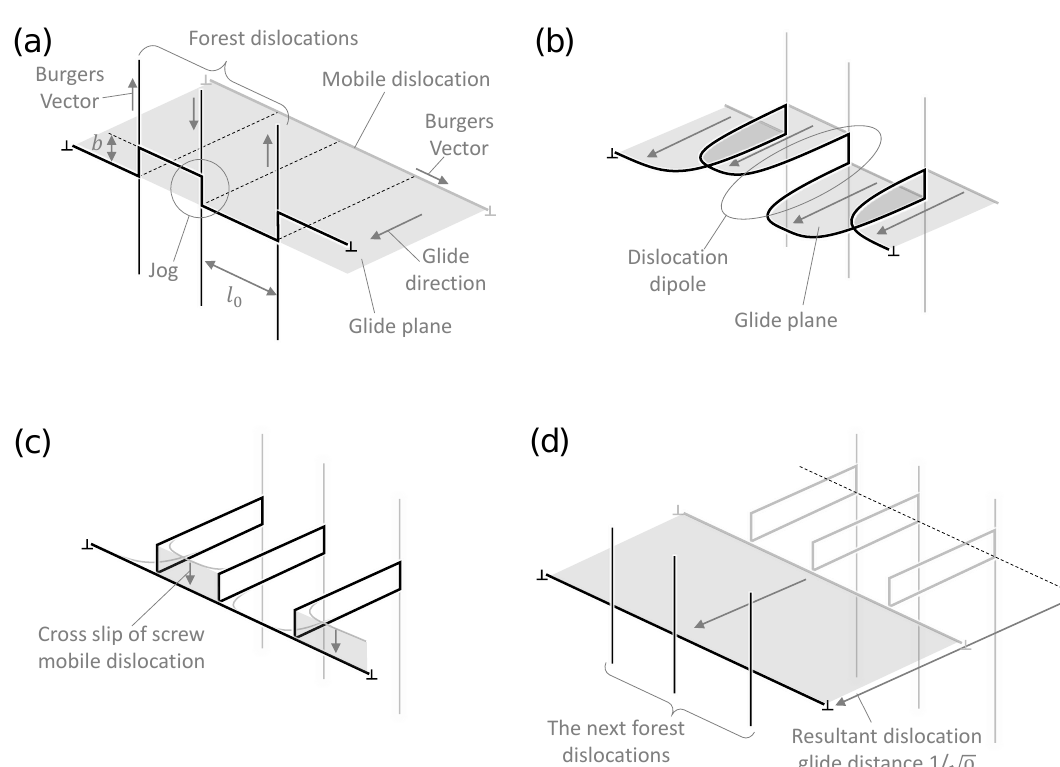
Figure 3. Schematic illustration of the process of a gliding dislocation to overcome a dislocation forest: ( a ) intersection of forest dislocations; ( b ) glide with jogs; ( c ) pinch-off of dipoles; and ( d ) glide without